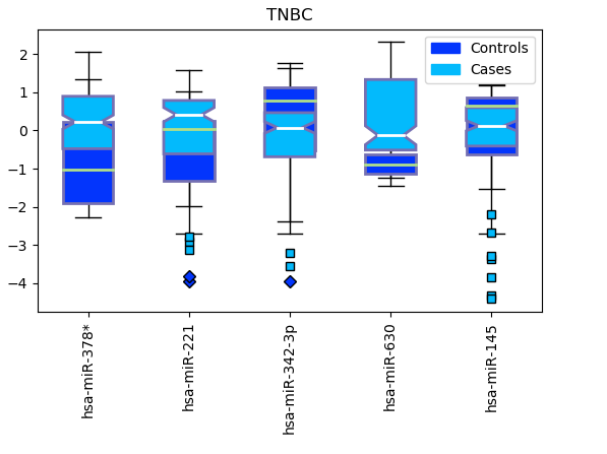
Figure 10. Results of 10 runs of the recursive ensemble feature selection for the TNBC discrimination example: The x axis cuts at 5 variables, which is where most evaluations cross the average 0.90 accuracy stop parameter.